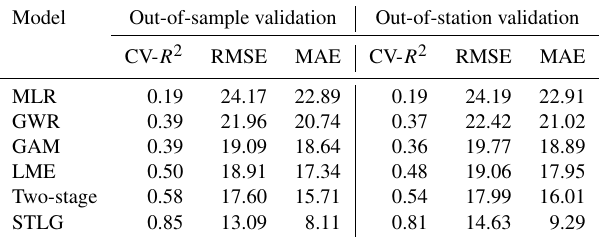
Table 4. Comparison of the model performances of widely used models and the STLG model in estimating PM 2 . 5 from Himawari-8 data at 14:00LT in 2018 in China ( N =